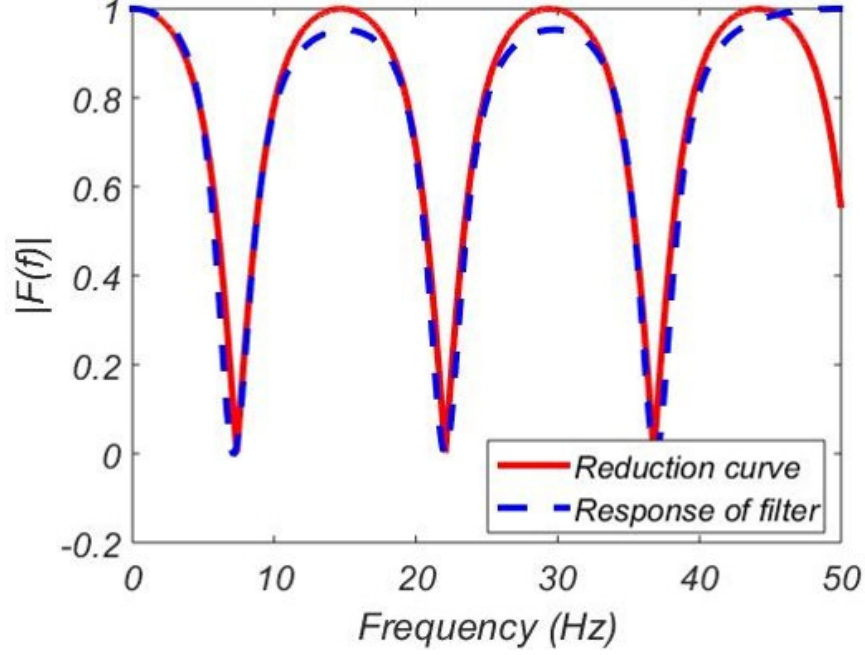
Figure 5. Target theoretical reduction spectrum due to the water column and frequency response of complex digital filter designed to simulate it.